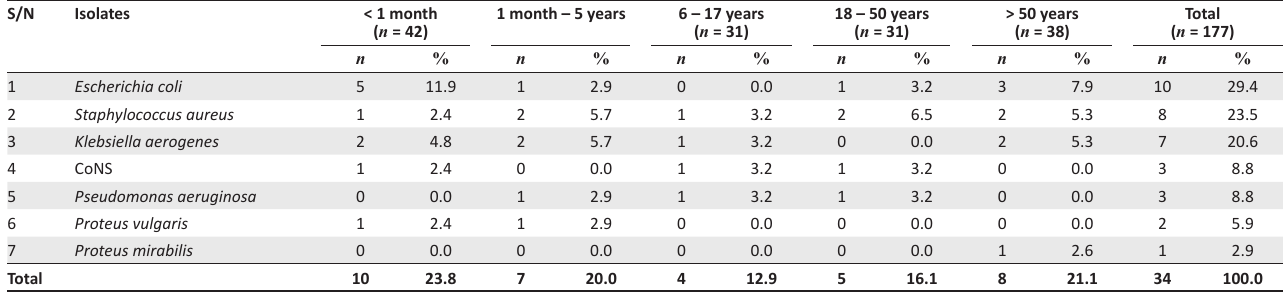
TABLE 3: Frequency of isolates from culture-positive broths among bloodstream infection cases by age group at the Federal Teaching Hospital, Ido-Ekiti, Nigeria, between June 2020 and February 2021. S/N